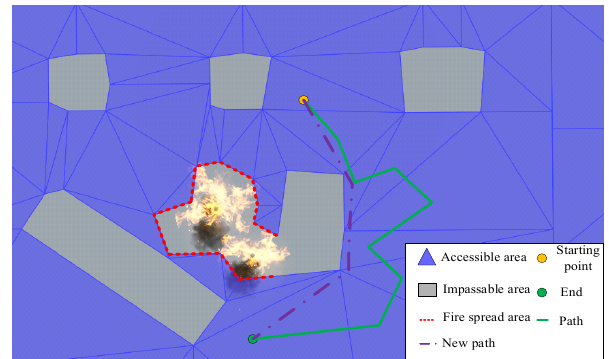
Figure 19. Pathfinding result graph after improving A* algorithm.